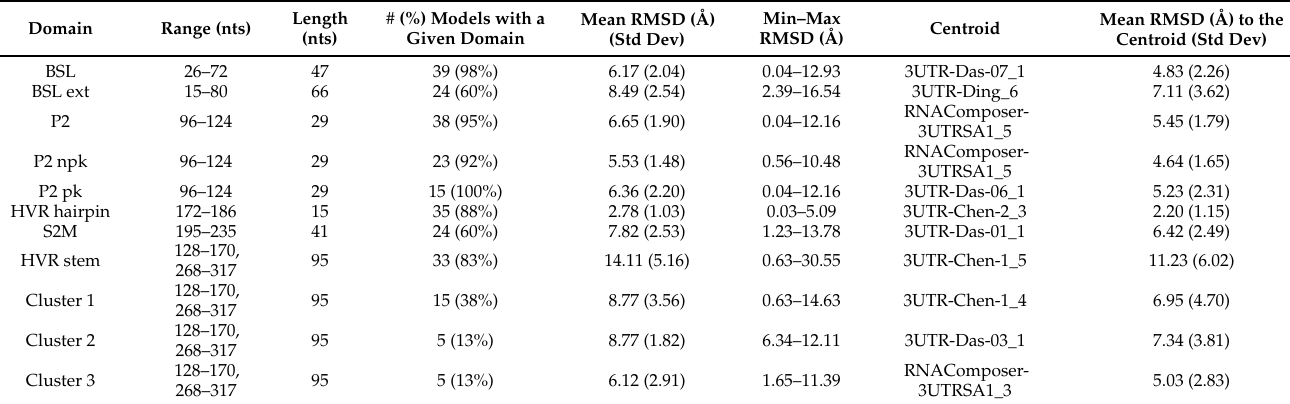
Table 4. The results of the analysis of the RMSD-based domain in the 3D models of 3 (cid:48) -UTR.